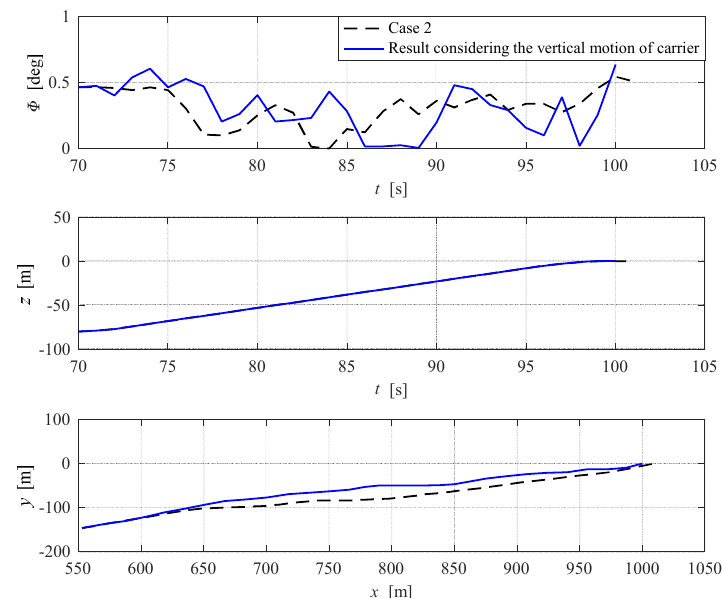
Figure 12. State of the helicopter in the landing task, considering the 3D motion of the carrier.